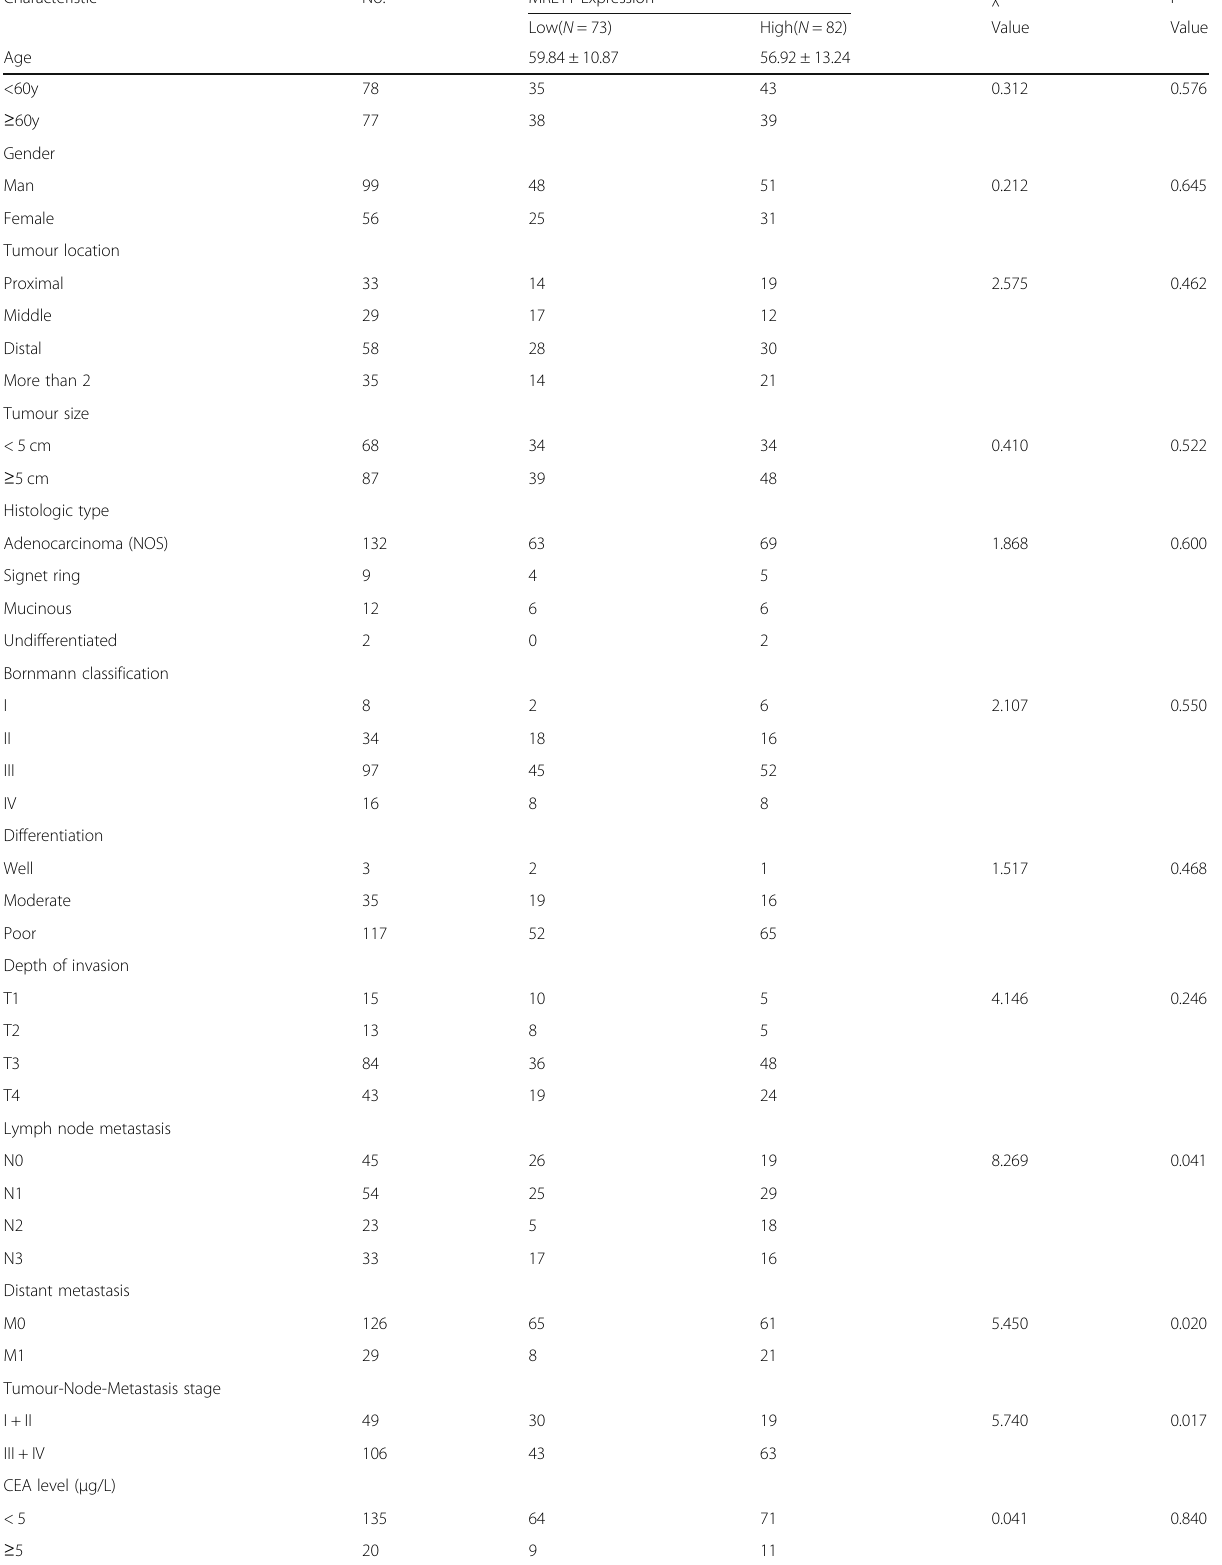
Table 2 Associations of MRE11 expression with clinical parameters in